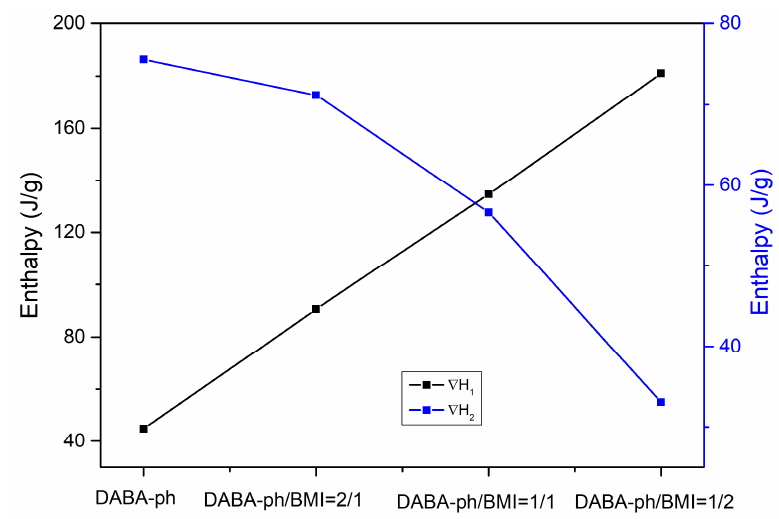
Figure 2. Enthalpy of DABA-Ph/BMI copolymers with various proportions.